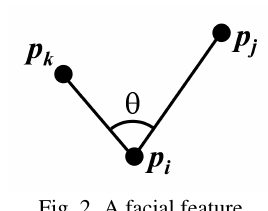
Fig. 2. A facial feature.